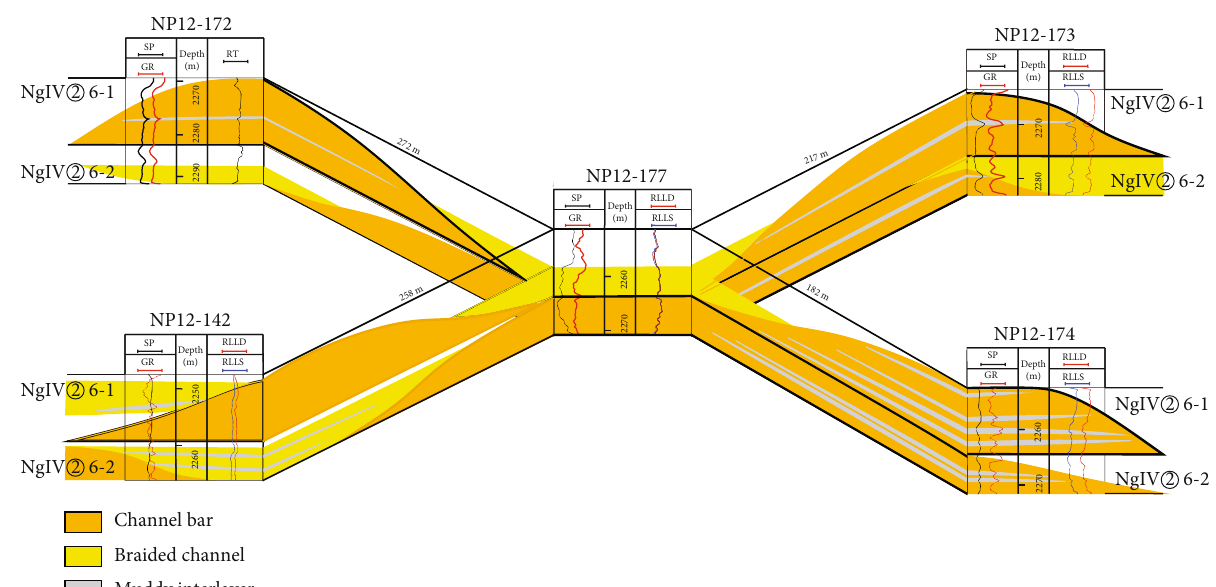
Figure 14: Static distribution model of NP12-177 well group in Nanpu 1-29 Area. Injection well NP12-177, the water injection method is general water injection and the water injection depth of 2258.11-2268.19m.